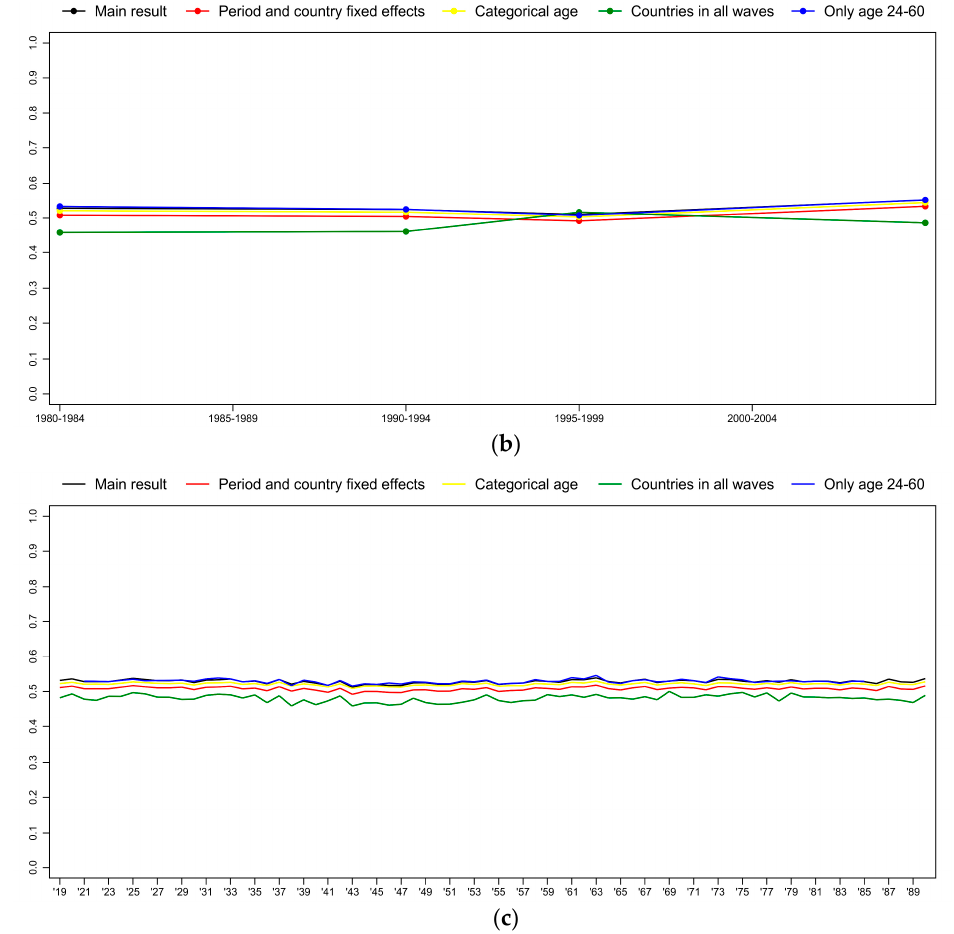
Figure 6. Robustness of the results: ( a ) Age, ( b ) period, and ( c ) birth-cohort effects on importance of good hours (hierarchical age-period-cohort regression models). The y -axis shows the predicted value of the dependent variable (for an average respondent).